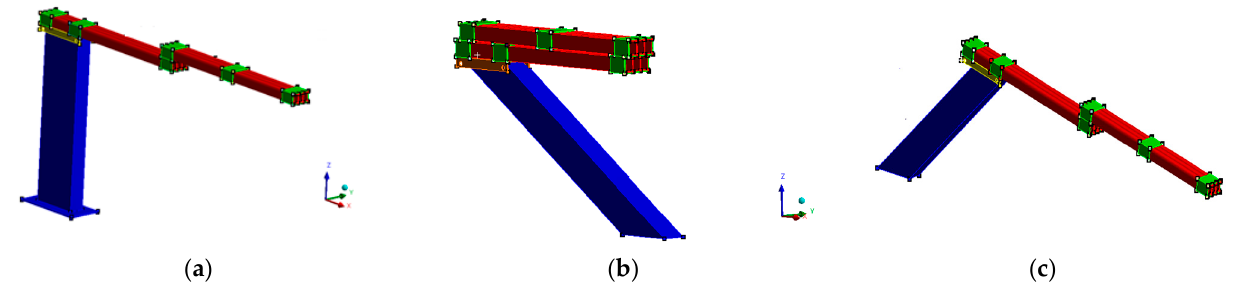
Figure 7. The 5 ‐ DOF robot manipulator’s common operating configurations: ( a ) Configuration 1, ( b ) Configuration 2, and ( c ) Configuration 3.